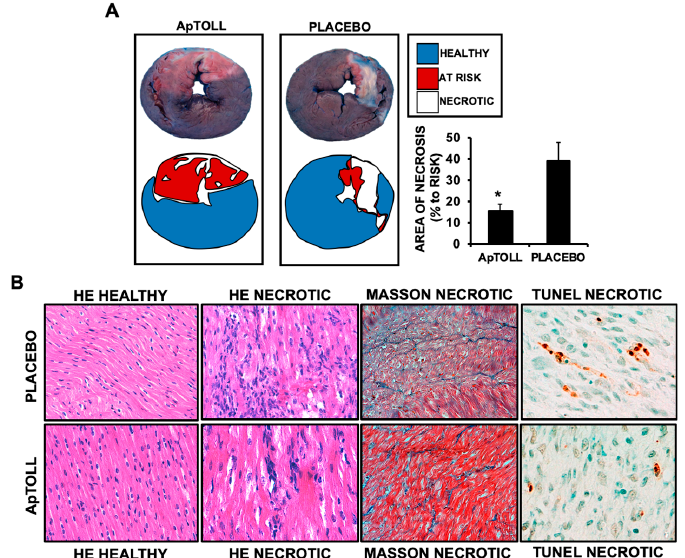
Figure 3. ( A ) Evans blue / TTC double staining performed in 0.5 cm heart sections isolated 7 days after IR from pigs treated with 0.078 mg / kg ApTOLL of Placebo (N = 9 ApTOLL / 8 Placebo. Mean ± SD. * p < 0.002 Placebo (Vehicle) vs. ApTOLL). ( B ) Left panels: H / E staining of heart sections from healthy and necrotic areas of hearts collected from pigs treated with 0.078 mg / kg ApTOLL or Placebo. Middle Right panel: Masson Trichrome staining of necrotic sections. Right panel. Tunel assay staining of necrotic sections. N = 5 ApTOLL /